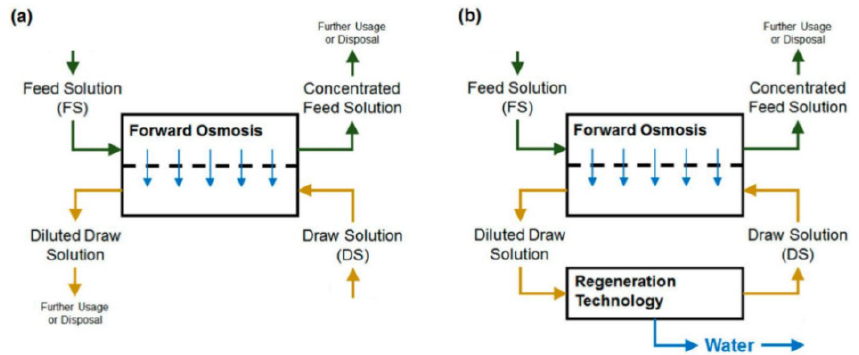
Figure 2. Schematic diagram of the FO process ( a ) without draw solution regeneration, and ( b ) with draw solution regeneration [17].